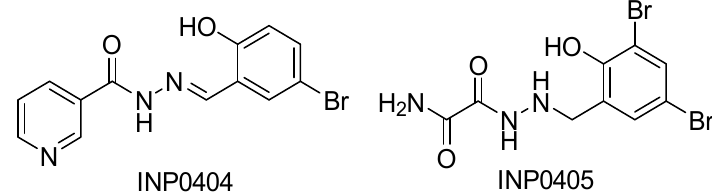
Figure 11. Structure of SA inhibitors INP0404 and INP0405.